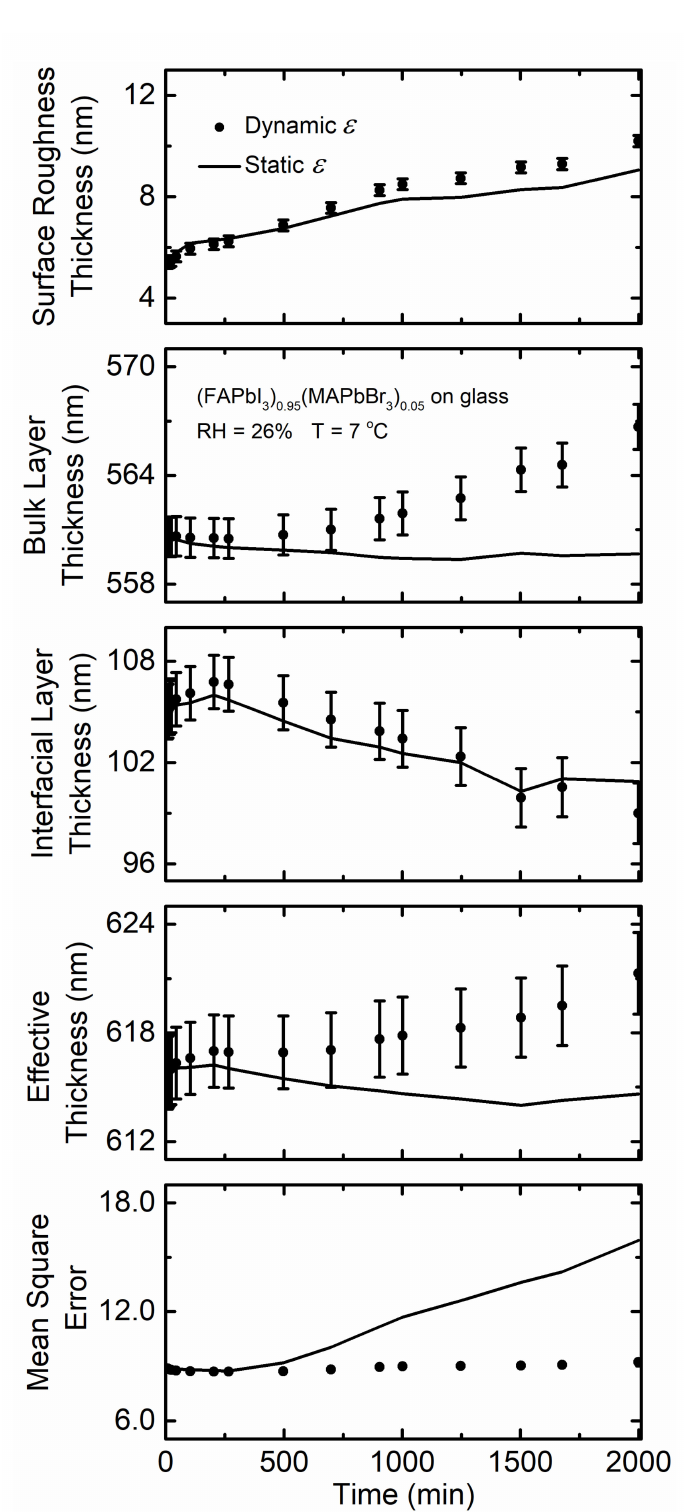
Figure 7. Surface roughness thickness, bulk layer thickness, interfacial layer thickness, effective perovskite thickness, and the quality of fit between the model and experimental ellipsometric spectra in the terms of mean square error as functions of time for (FAPbI 3 ) 0.95 (MAPbBr 3 ) 0.05 thin film deposited on soda lime glass when exposed to 26% RH at 7 ◦ C. Values obtained assuming the initial spectra in ε (time = 0 min; static) prior to exposure are represented by a solid line, and spectra in ε fit at each time point (dynamic) are represented by solid circles. RH is introduced at 5